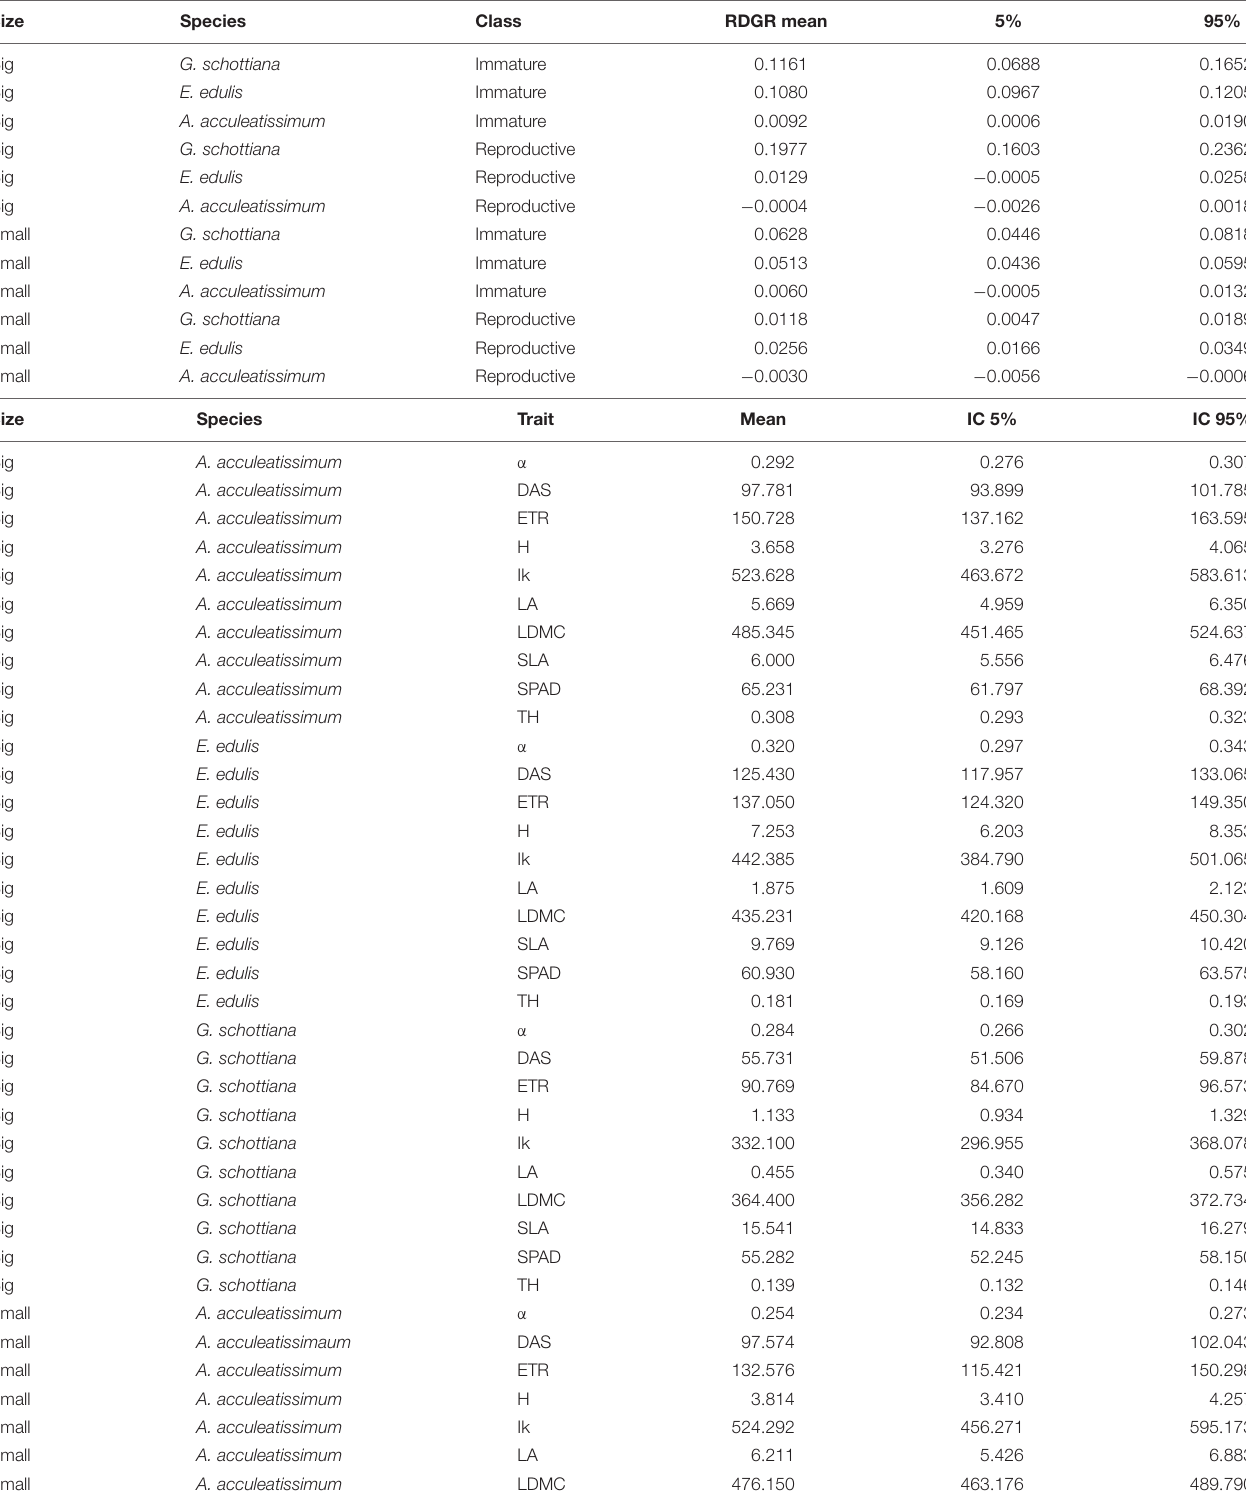
TABLE 5 | The bootstrap confidence intervals for mean of: relative diameter growth rate (RDGR), height (H, cm), basal stem diameter (BSD, mm), leaf area (LA, cm 2 ), leaf thickness (TH, mm), and leaf dry matter content (LDMC, mg · g − 1 ), specific leaf area (SLA, m 2 · kg − 1 ), parameter α (alpha, electrons/photons), maximum electron transport rate [ETRmax, µ mol electrons/(m 2 · s)], I K , [ µ mol photons/(m 2 · s)], and chlorophyll concentration